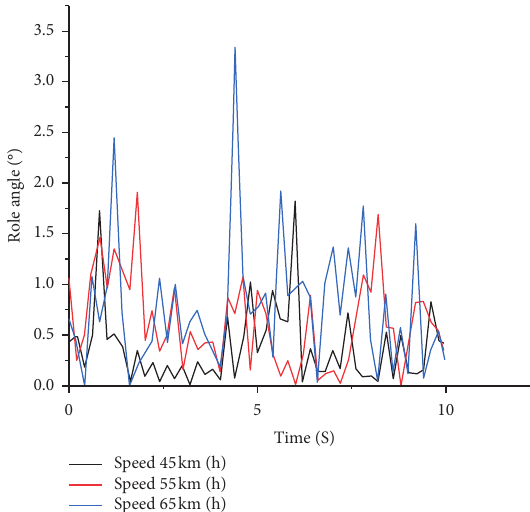
Figure 14: Roll angle change of the braking lane changing